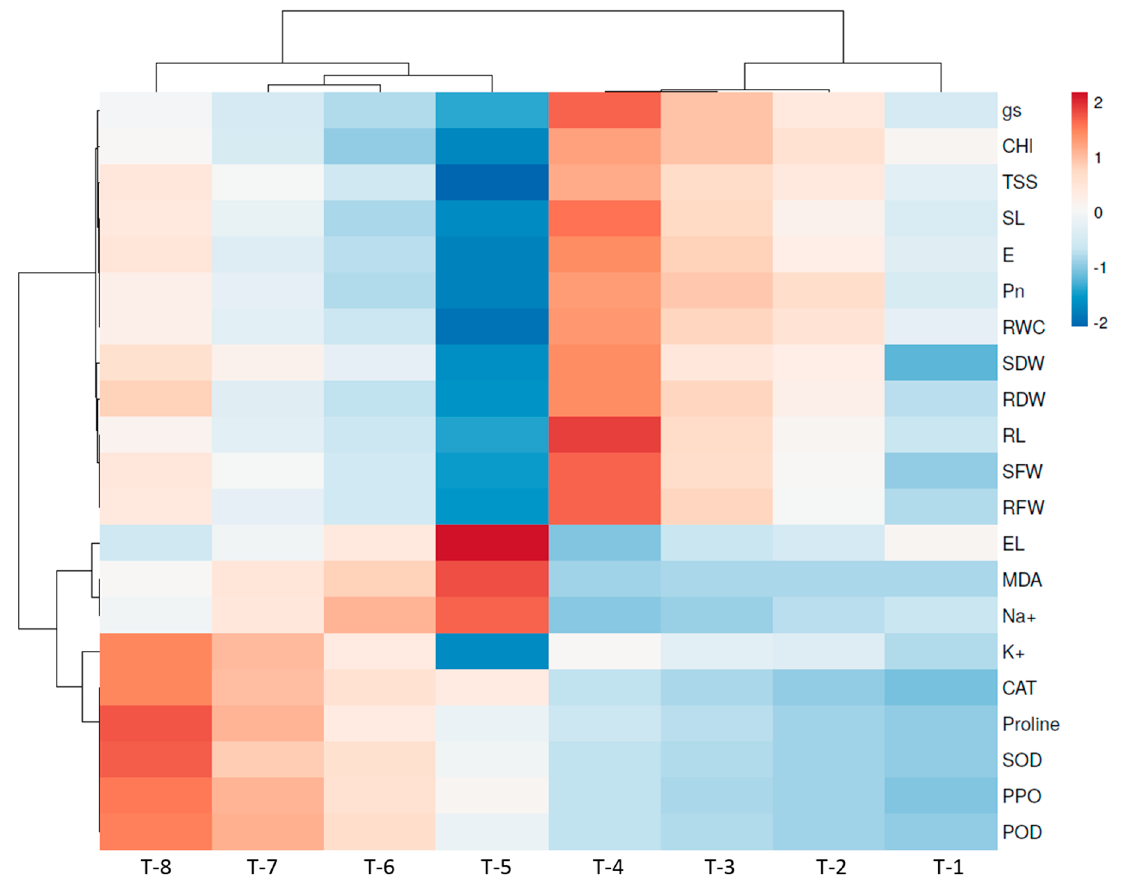
Figure 9. Heatmap multivariate data analysis showing the responses of different variables of plants against the different treatments applied. T-1: Un-inoculated control; T-2: SNP; T-3: PGPR ASN-1; T-4: PGPR ASN-1 + SNP; T-5: NaCl (200 mM); T-6: NaCl + SNP; T-7: NaCl + PGPR ASN-1; T-8: NaCl + PGPR ASN-1 + SNP. SL: shoot length; RL: root length; SFW: shoot fresh weight; SDW: shoot dry weight; RFW: root fresh weight; RDW: root dry weight; Chl: chlorophyll; Pn: net photosynthesis rate; gs: stomata conductance; E: transpiration rate; RWC: relative water content, EL: electrolytes leakage; TSS: total soluble sugar; CAT: catalase; SOD: superoxide dismutase; POD: peroxidase; PPO: polyphenol oxidase; MDA: malondialdehyde.